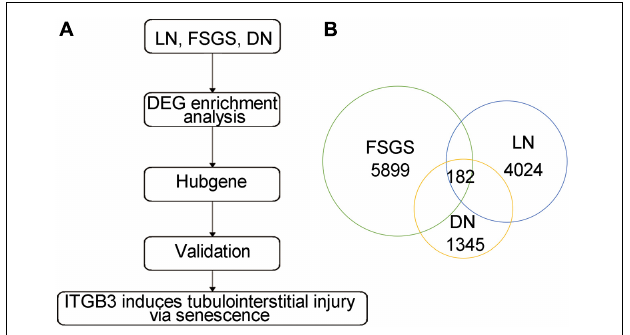
FIGURE 1 | The common DEGs among different types of CKD. (A) The strategy of candidate gene screen. (B) The common DEGs based on DN, LN, and